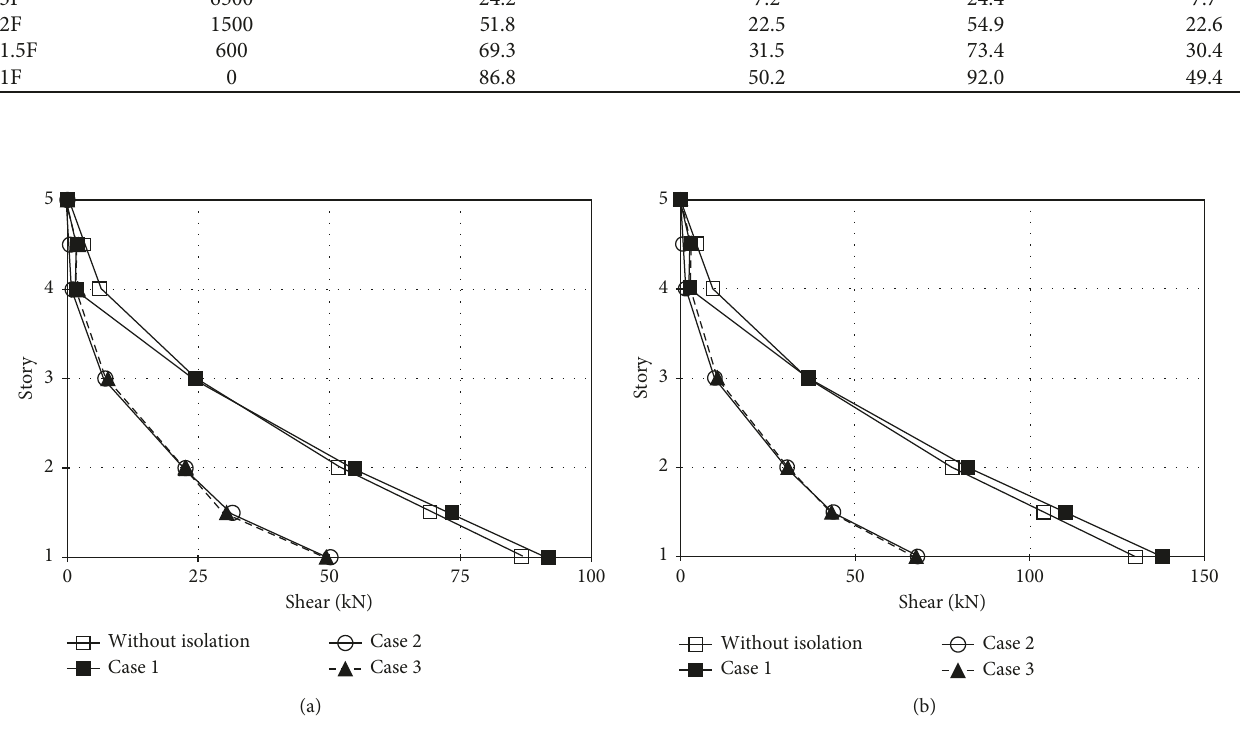
Figure 15: Average maximum story shear result. (a) DBE. (b)